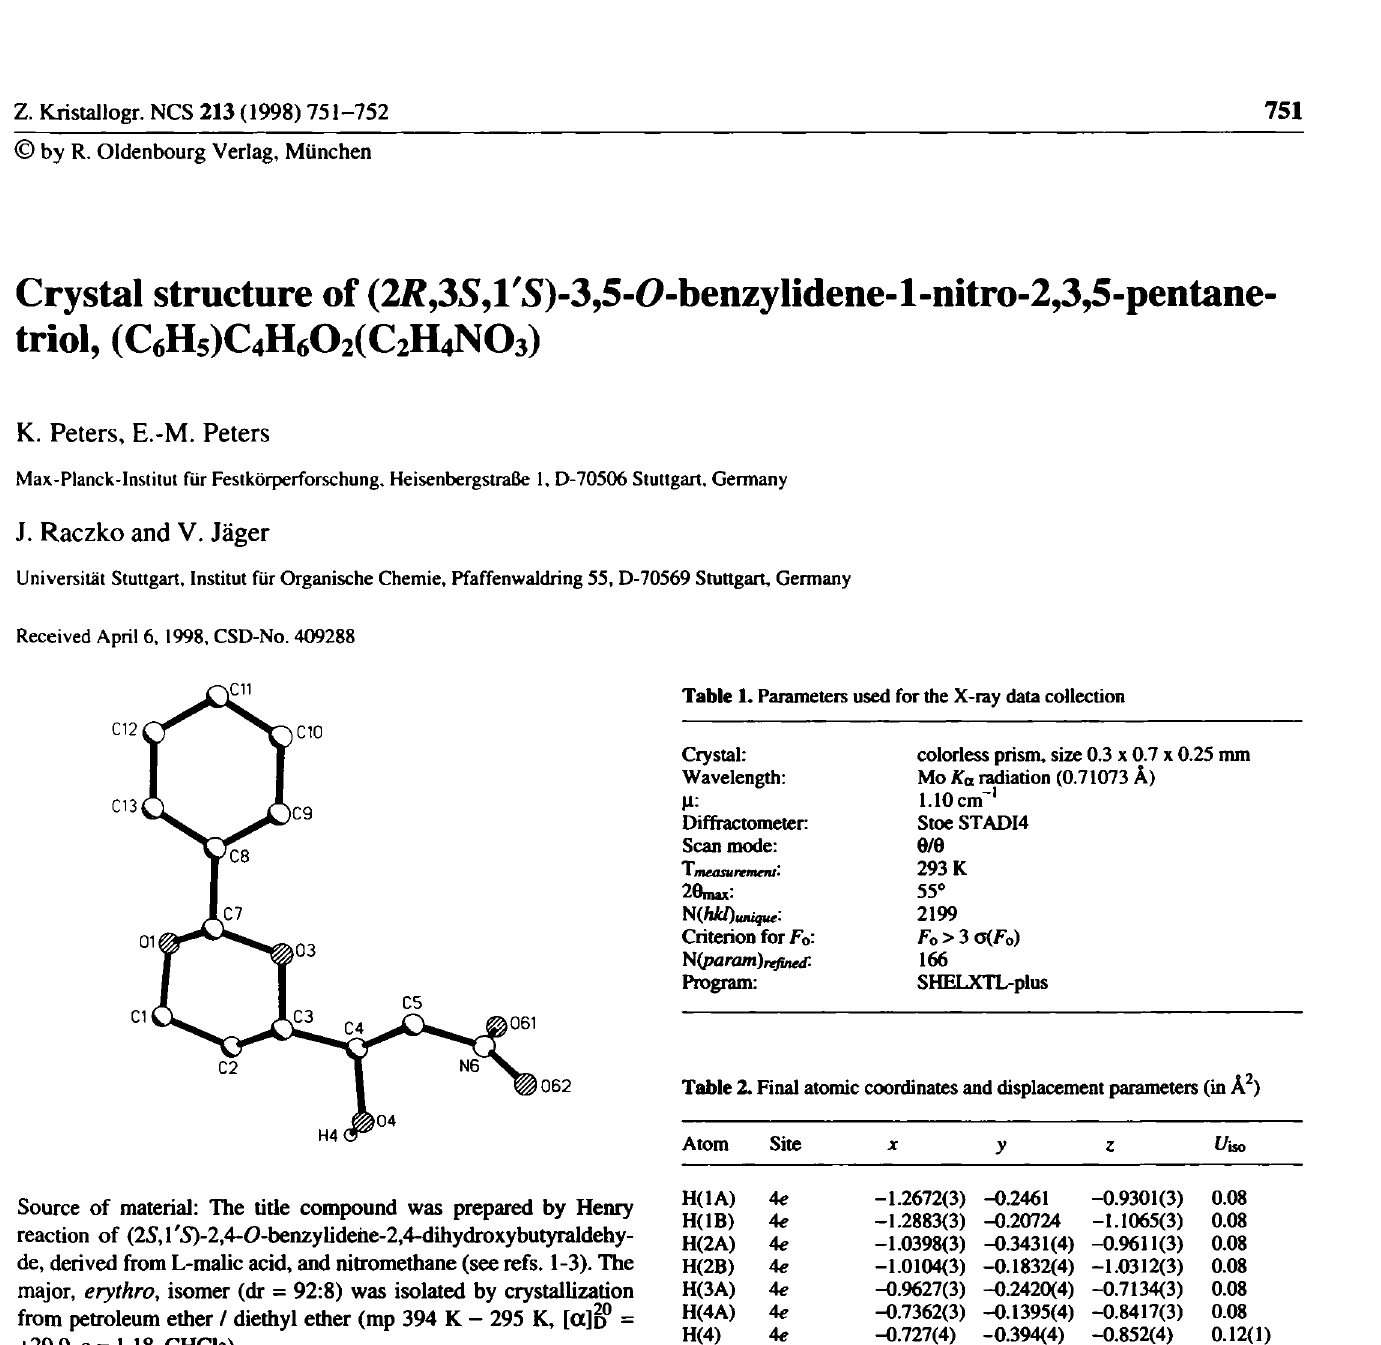
Table 2. Final atomic coordinates and displacement parameters (in